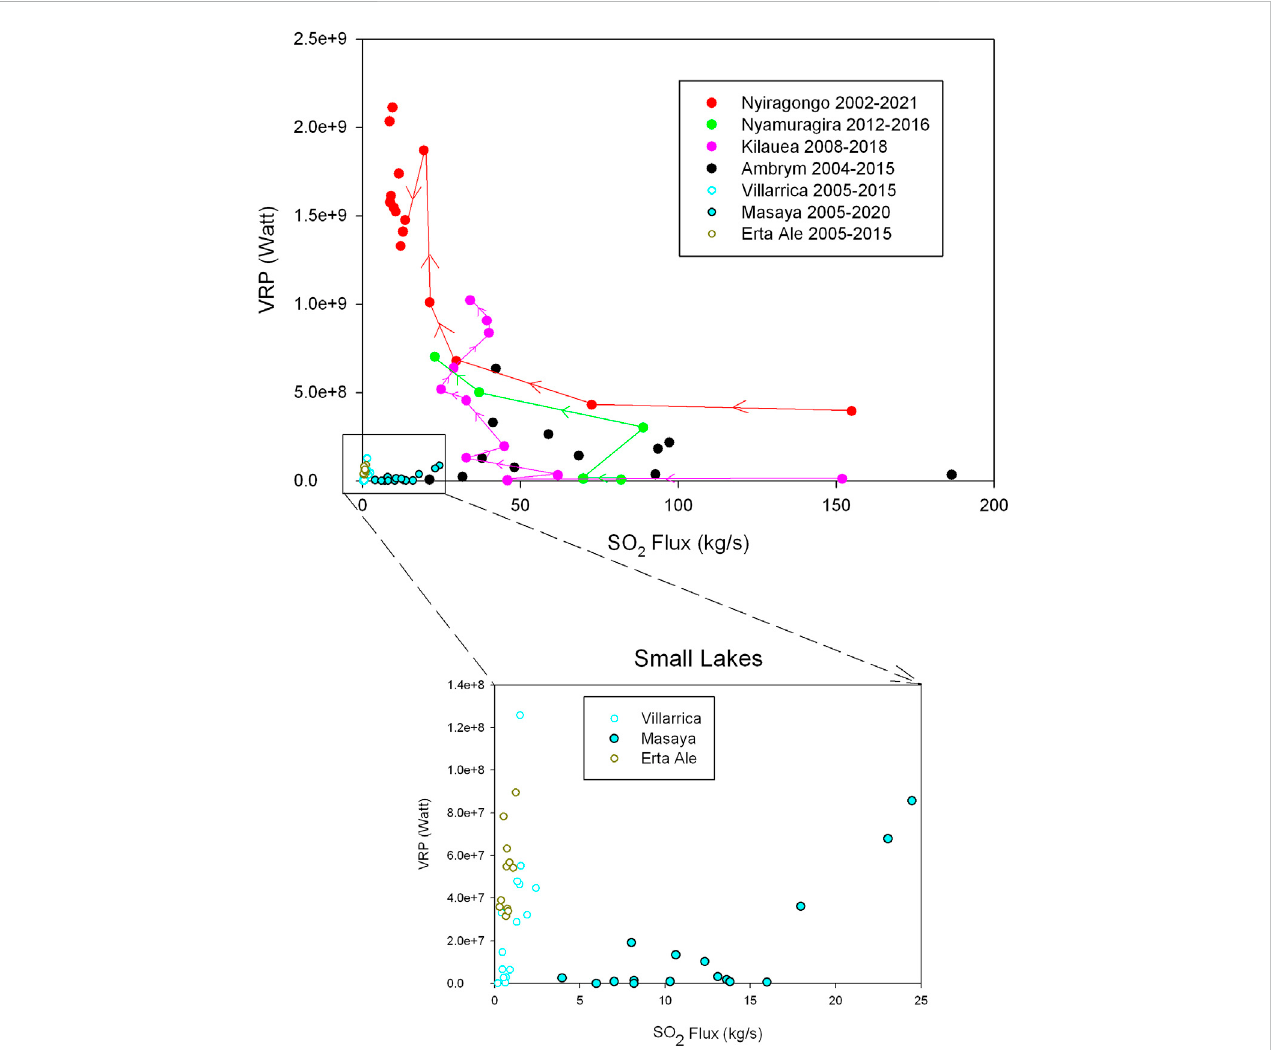
FIGURE 10 Diagram of the SO 2 fl ux versus VRP for lava lakes of the world. For the sake of clarity, each data point represents the average, over a year, of monthly maximum VRP. Arrows between points represent evolutions from year to